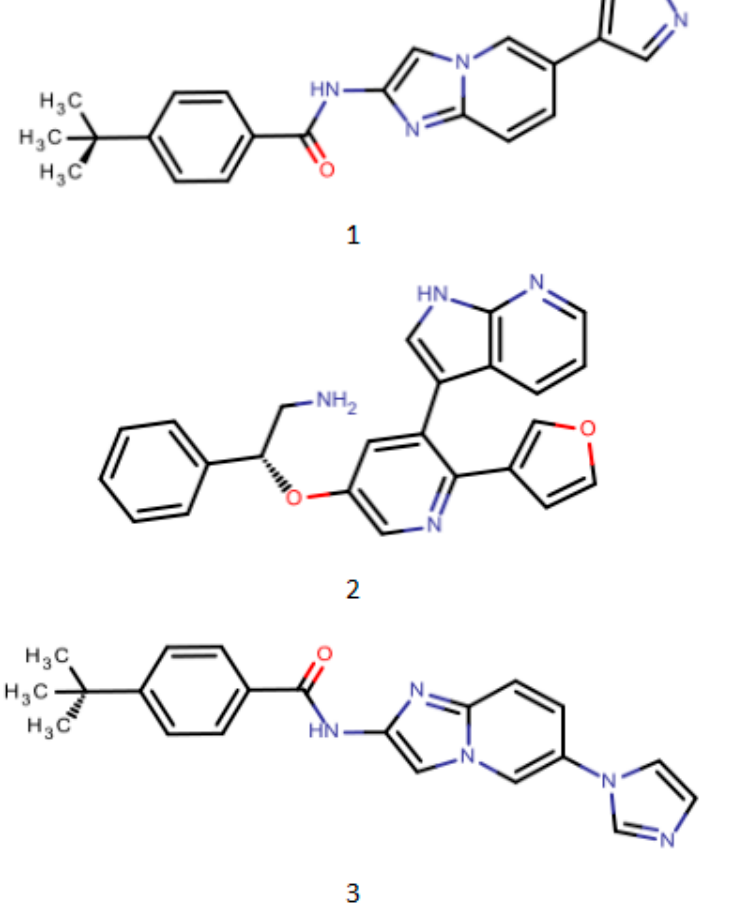
Figure 3. PharmaGistpharmacophore model development training set representative compound structure schematic (1. PDB ID: 4BNH 2. PDB ID: 4BID 3. PDB ID: 3VW6).